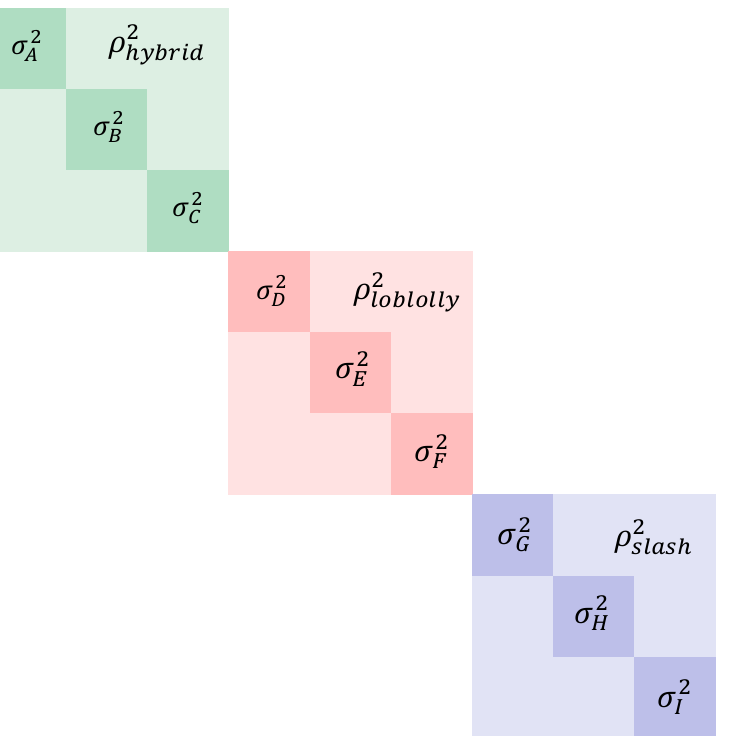
Figure 2. A visualization of the covariance matrix specification to account for independent taxa, individual pedigree-based additive variances, and genetic correlations within taxa and among isolates. σ 2 corresponds to the additive variance for slash × P . caribaea hybrids with the Suwanee isolate, σ 2 B corresponds to the additive variance for slash × P . caribaea hybrids with the Volusia isolate, and so on. Genetic correlations within a taxon are denoted ρ 2 hybrid